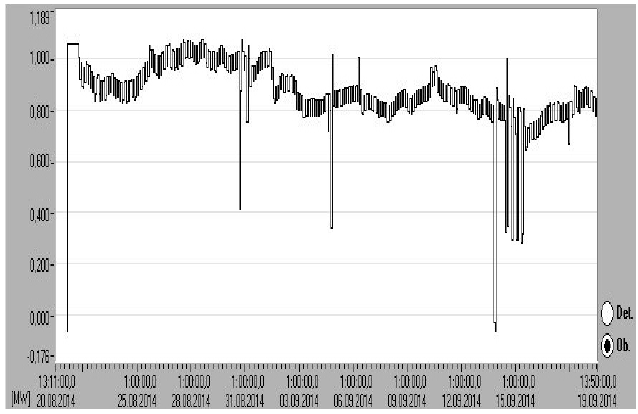
Fig. 5. Course of entire active power over the whole period observed at the location of BS 1